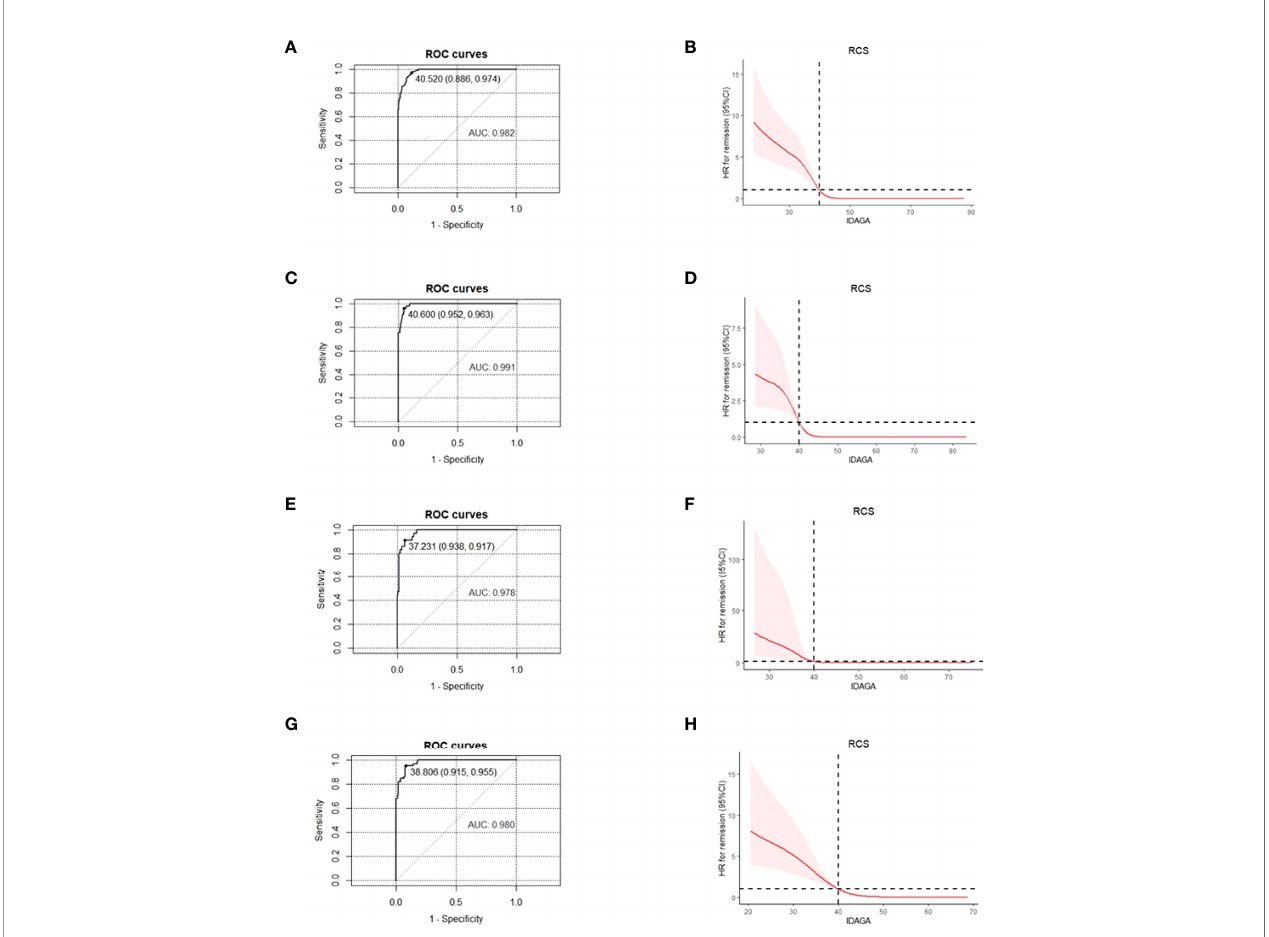
FIGURE 2 | For patients of different age- groups, ROC and RCS curves were used to fi nd the optimal cut-off point for IDAGA for IDAGA to de fi ne the partial remission, with GA ≤ 23% and insulin dose ≤ 0.5 u/kg/day being the diagnostic criteria. All age- groups: ROC (A) , RCS (B) ; ≤ 12 years group: ROC (C) , RCS (D) ; 12- 18 years group, ROC (E) , RCS (F) ; ≥ 18 years group, ROC (G) , RCS (H) . ROC, receiver operating characteristic; RCS, restricted cubic spline; IDAGA, insulin dose- adjusted glycated albumin; GA, glycated